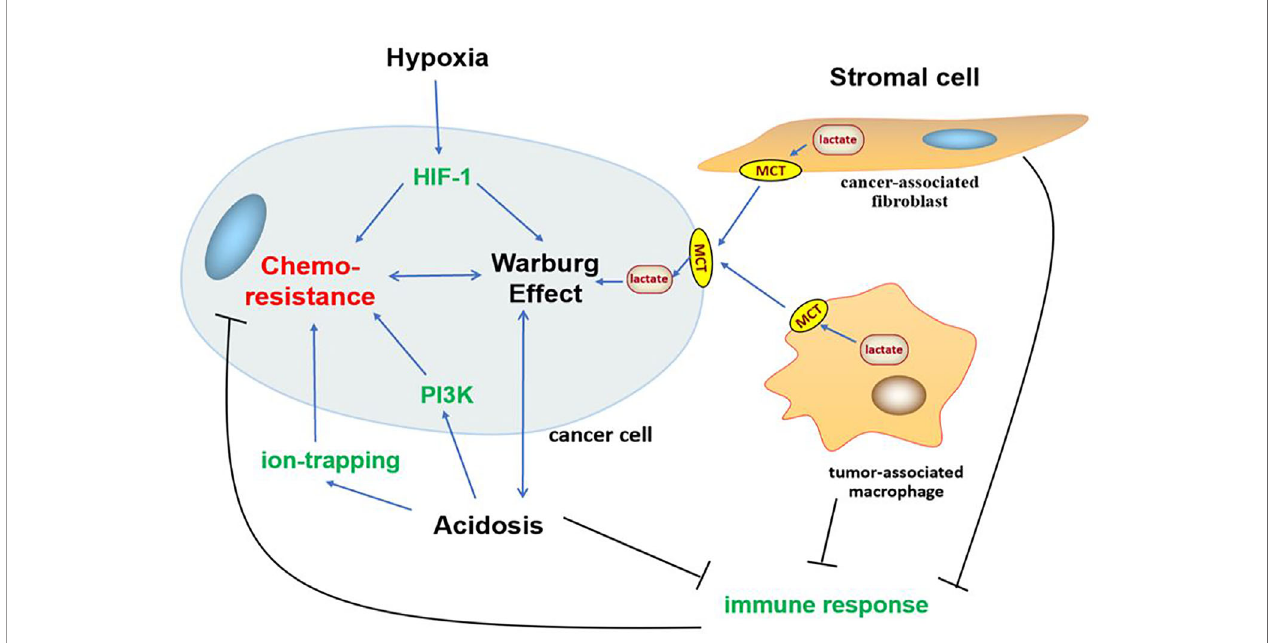
FIGURE 3 | Association between Warburg effect-induced chemoresistance and tumor microenvironment. Tumor microenvironment undergoes a series of adjustments such as hypoxia, acidosis, and stromal cell formation to survival, which interact with glycolysis and oncogene PI3K, HIF-1 signaling pathways to induce chemoresistance in